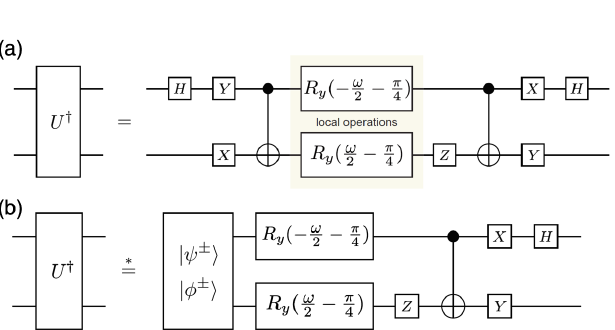
FIG. 1. The quantum circuit for the generation of the eigen- states of the XY Hamiltonian. (a) The decomposition of the unitary U † that transforms the eigenstates of a noninteracting Hamiltonian to the eigenstates of the XY Hamiltonian. Full control of the system parameter w that specifies a particular Hamiltonian is granted by local operations. (b) The local unitaries ð YH Þ ⊗ X together with the first CNOT transform the computa- tional basis states into the four Bell states and we obtain the circuit shown in (b). The asterisk (*) is to remind us that this simplification is valid only for certain inputs.